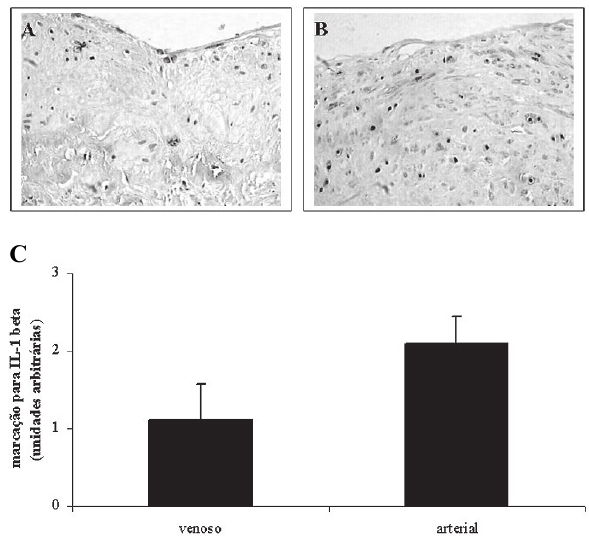
Fig. 3 - Imuno-histoquímica para Isoleucina-1ß em segmentos de veia safena humana cultivada em regime venoso (A) e arterial (B) por 24 horas. (C) Quantificação da marcação para Interleucina- 1ß em amostras de 9 indivíduos. A análise foi realizada por um observador cego para condição de cultivo, sendo dada pontuação de 0 a 3 proporcionalmente à quantidade de marcação. (Aumento de